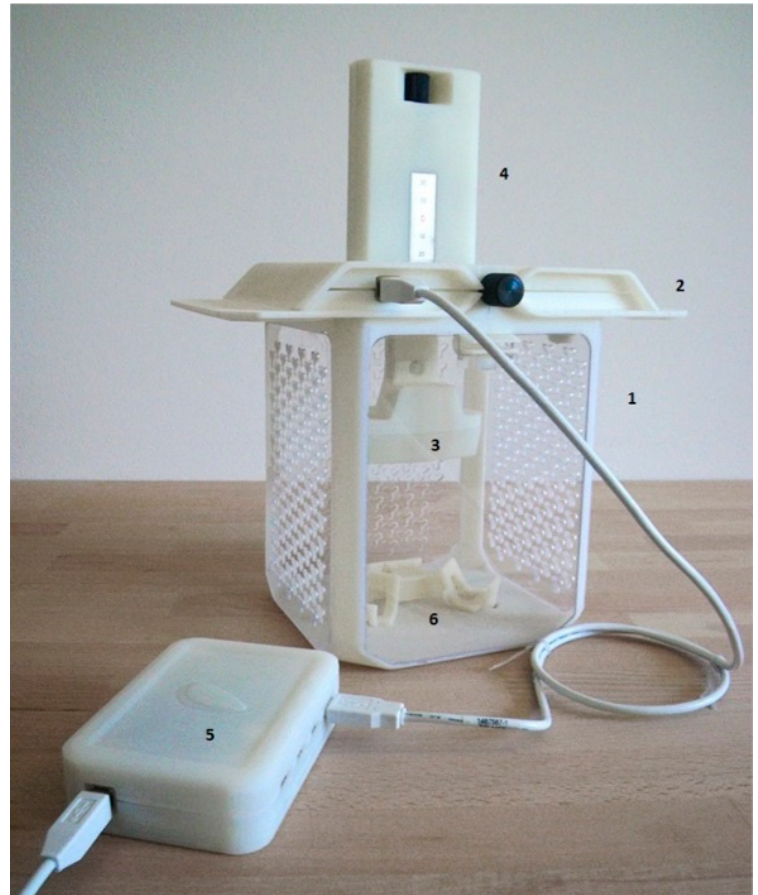
Figure 2. SmartShell components: 1—sensor tank; 2—sensor tank cap; 3—IR sensor containment chamber; 4—positioning system of sensor; 5—external case containing hub; 6—mollusc support.